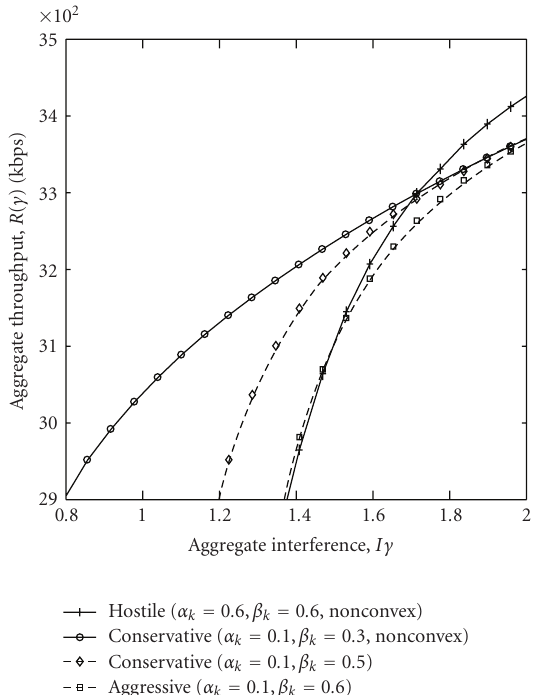
Figure 5: Aggregate opportunistic throughput versus aggregate interference in multiband detection. Convex systems are plotted in dashed line.